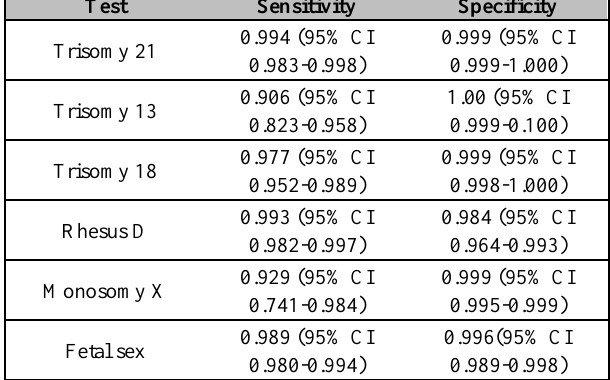
Table 1: Meta-analysis of diagnostic accuracy for cffDNA– based non-invasive prenatal test confirmed by sensitivity and specificity ratio of common